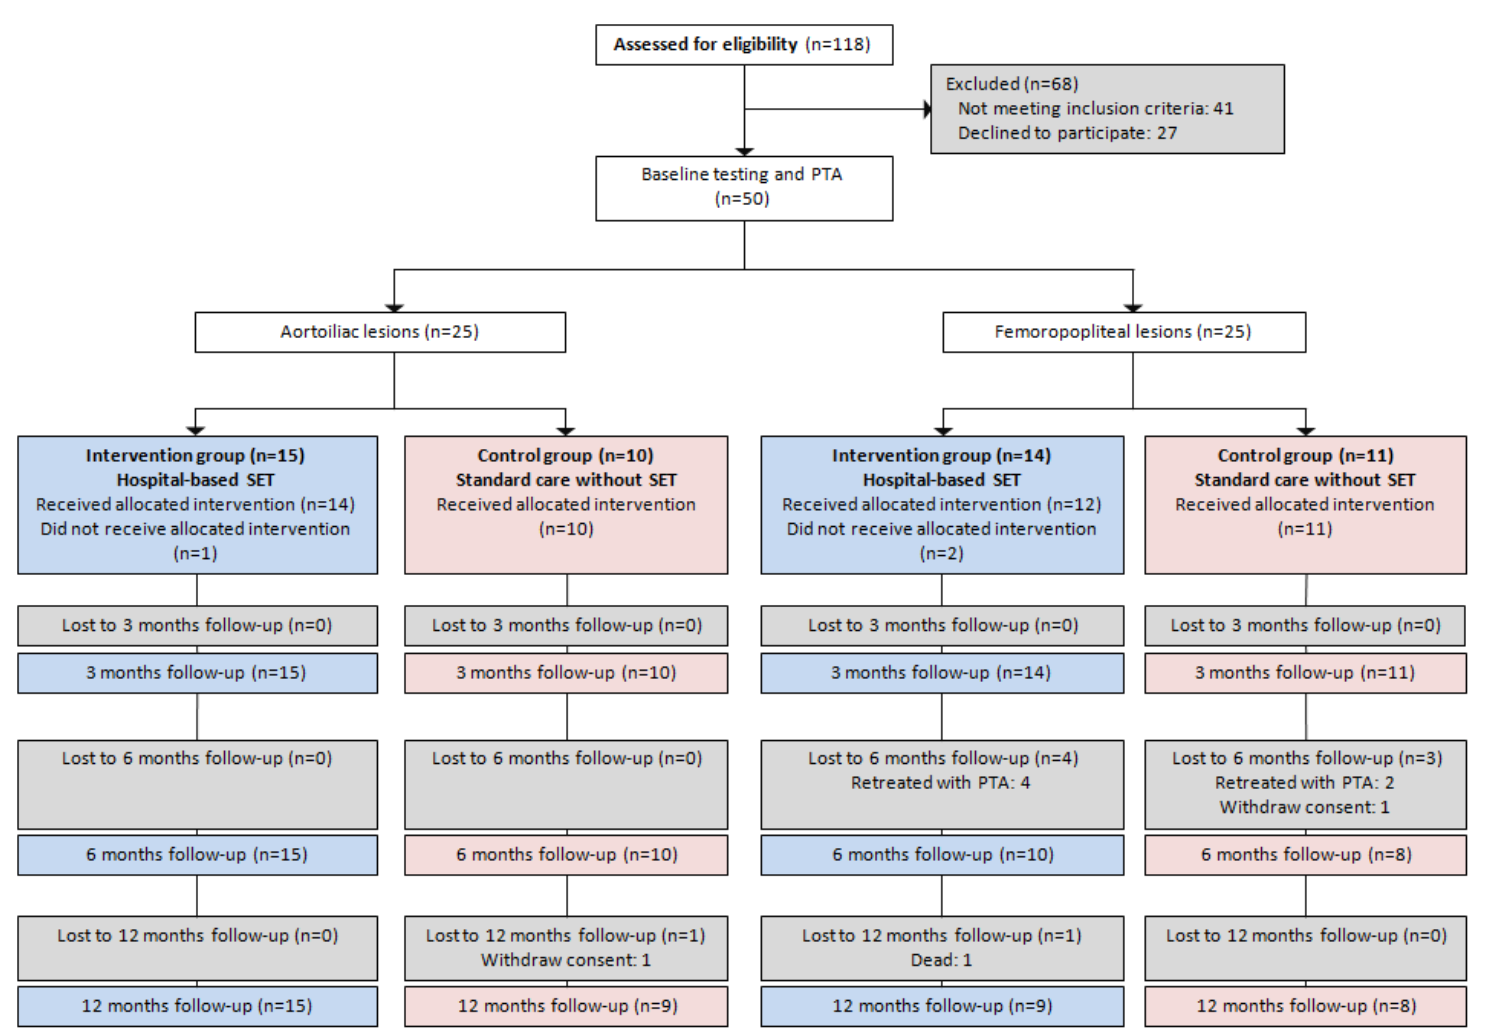
Figure 1. CONSORT flow chart of the